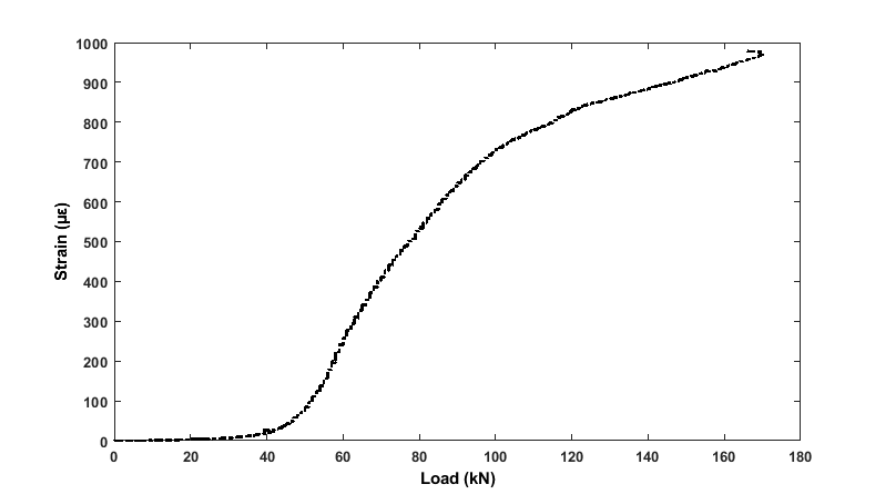
Figure 17. Strain (bottom vibrating wire) vs. Load.